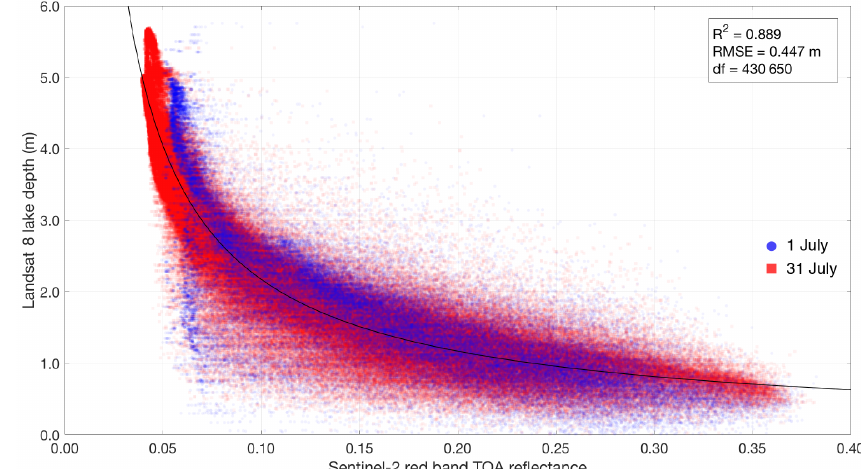
Figure 4. The empirical power-law regression (solid black curve, equation y = 0 . 2764 x − 0 . 8952 ) between Sentinel-2 red-band TOA re- flectance and Landsat 8 lake depth. Degrees of freedom (“df” in this figure) = 430650. The R 2 value indicates that the regression explains 88.9% of the variance in the data. The RMSE of 0.447m shows the error associated with calculating the Sentinel-2 lake depths using this